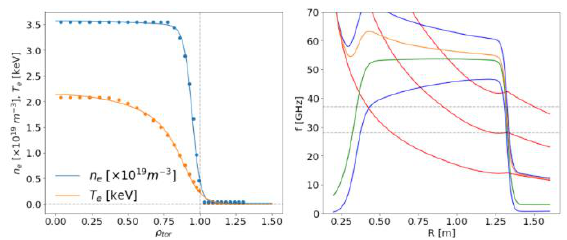
Fig. 14 : Left: density and temperature profiles for MAST Upgrade TRANSP prediction C1a. Right: the characteristic frequencies of this